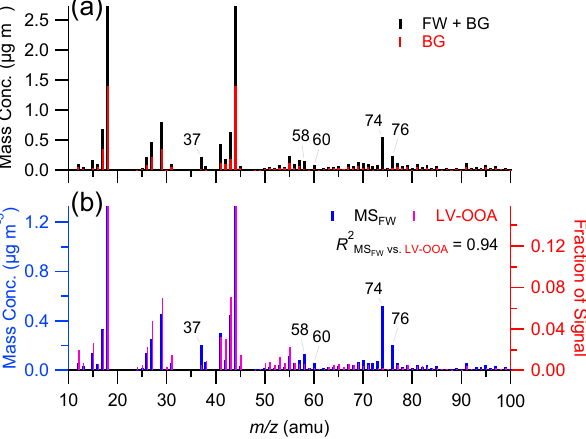
Figure 5. (a) Average mass spectra (MS) of OA during the fire- work period of Lunar New Year (23:30 on 9 February to 03:30 on 10 February) and the period of background (BG, 04:30–11:00, 10 February). (b) Comparison of the difference spectrum from (a) , i.e., MS FW + BG –MS BG , with the average LV-OOA spectrum in Ng et al. (2011a). Note that five m/z ’s – 37 ( 37 Cl + ) , 58 (NaCl + ) , 60 (Na 37 Cl + ) , 74 (KCl + ) , and 76 (K 37 Cl + / 41 KCl + ) – marked in the figure were dominantly from the fragmentation of inorganic salts during